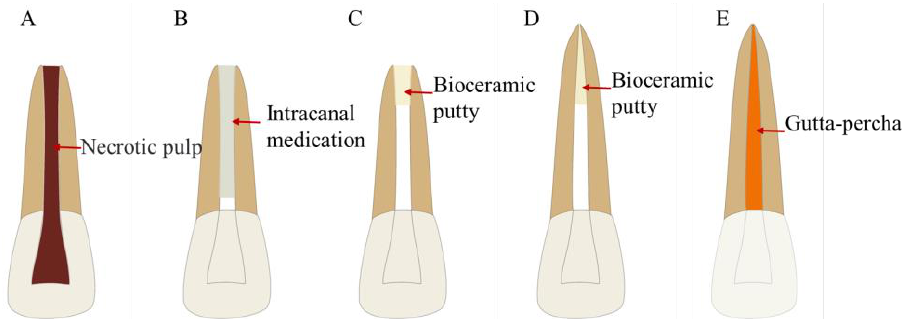
Figure 9. Treatment procedures for apexification. ( A ) Permanent teeth with incompletely developed apical foramen and pulp necrosis or periapical disease. ( B ) Root canal disinfection. ( C ) Apexification with bioceramics. ( D ) Root development. ( E ) Root canal filling.